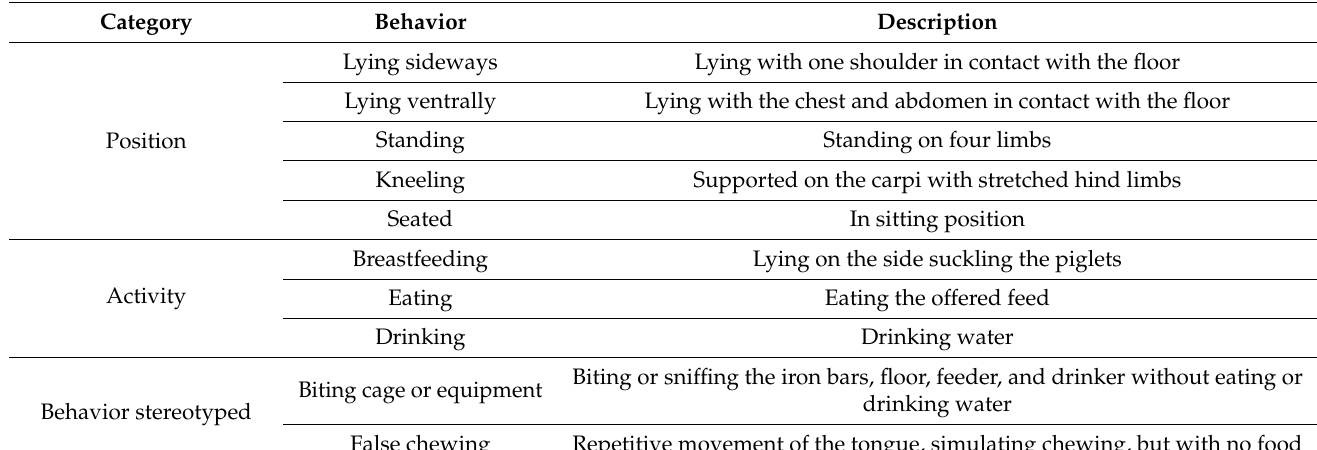
Table 3. Ethogram used for behavioral evaluation of sows in the lactation